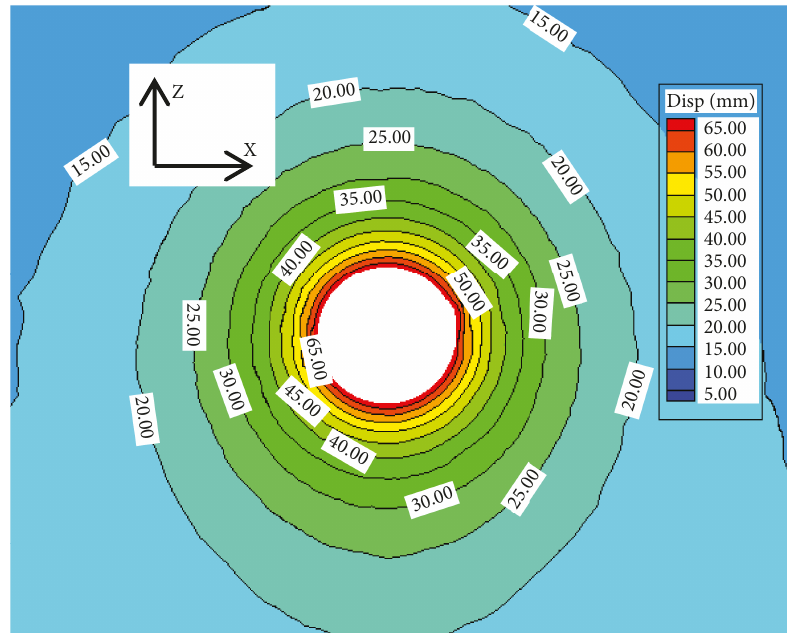
Figure 16: Resultant displacement of section A-A.